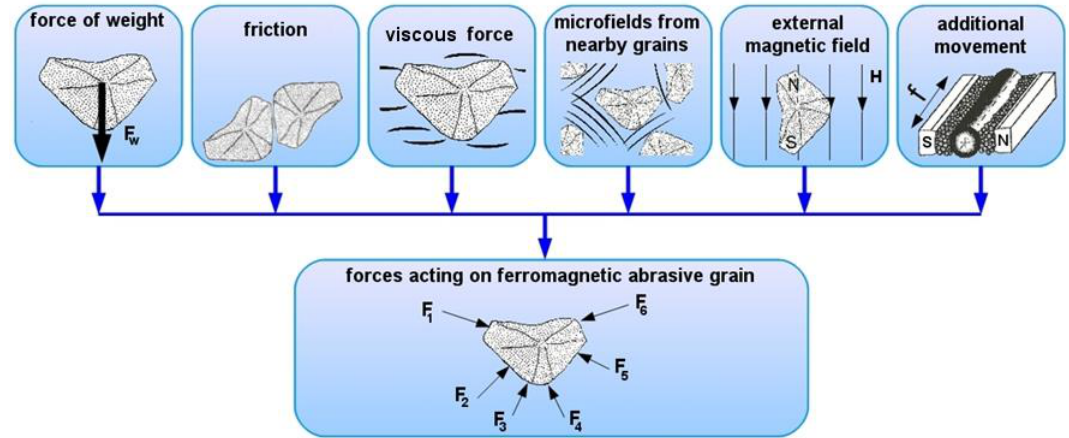
Figure 1. Factors determining force acting on ferromagnetic abrasive grains.